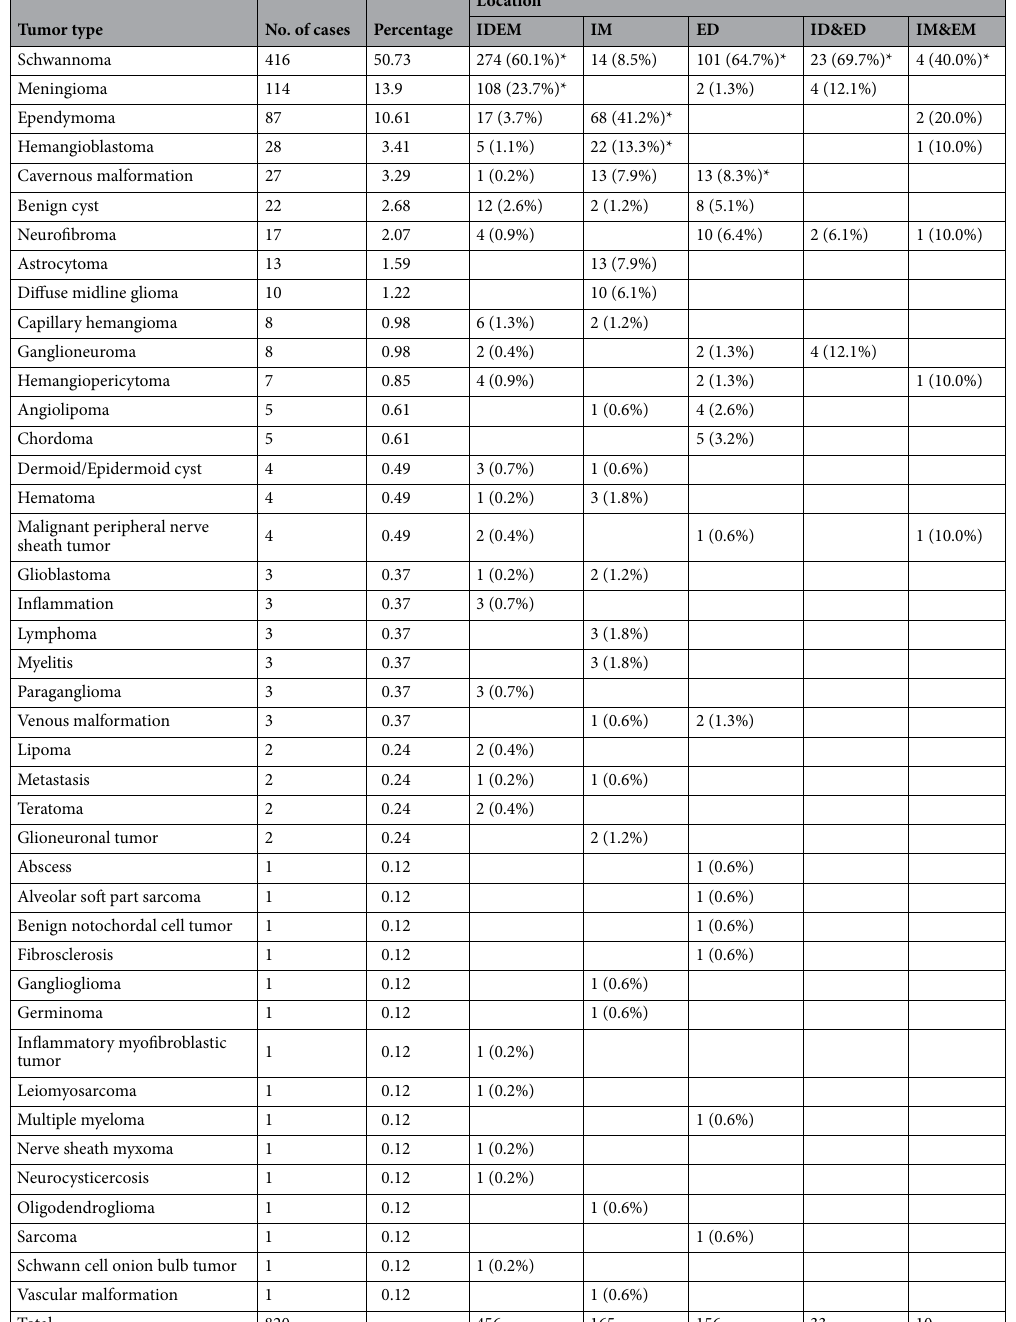
Table 2. Frequency of tumors by location. Asterisk indicates the two most common tumors by